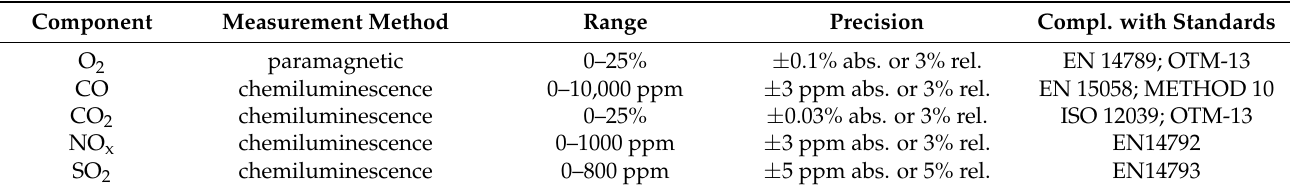
Table 3. Technical specification of the Testo 350 flue gas analyser.